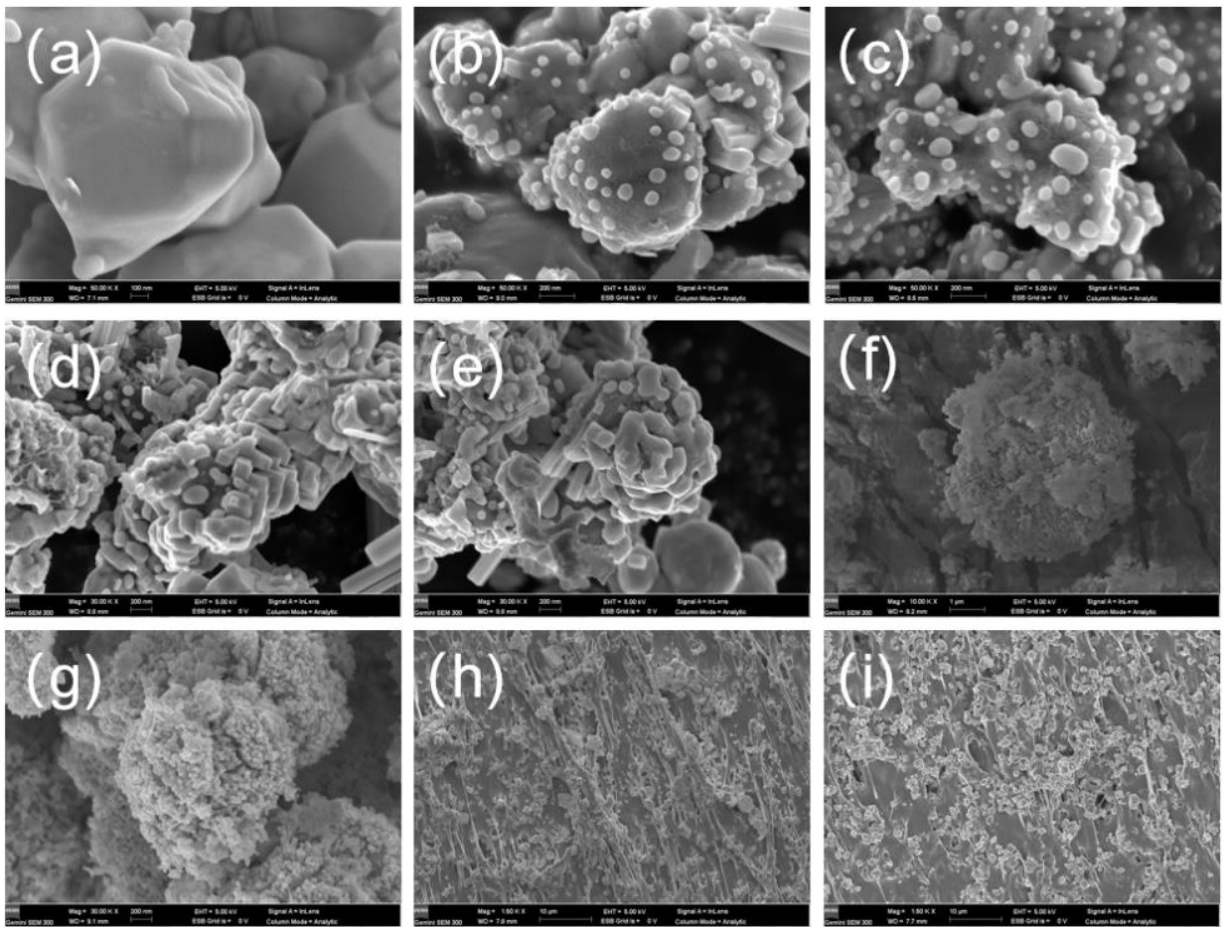
Figure 4. SEM images of ( a ) calcined W/PDA, ( b ) 0.1 mol/L of Gd 3+ to prepare W/Gd 2 O 3 , ( c ) 0.2 mol/L of Gd 3+ to prepare W/Gd 2 O 3 , ( d ) 0.3 mol/L of Gd 3+ to prepare W/Gd 2 O 3 , and ( e ) 0.4 mol/L of Gd 3+ to prepare W/Gd 2 O 3 . ( f ) W/PDA/GD(OH)CO 3 , ( g ) calcined product of W/PDA/GD(OH)CO 3 , ( h ) cross- sectional morphology of W/Gd 2 O 3 mixed powder PU coating fabric, and ( i ) cross-sectional